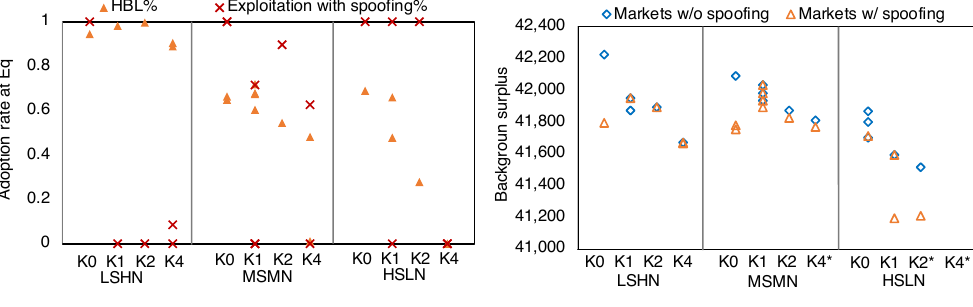
Figure 10. Comparisons of price discovery for equilibrium in each environment with different cloaking.